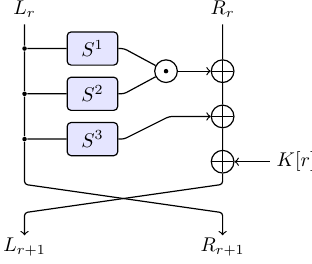
Figure 2: Round function of the